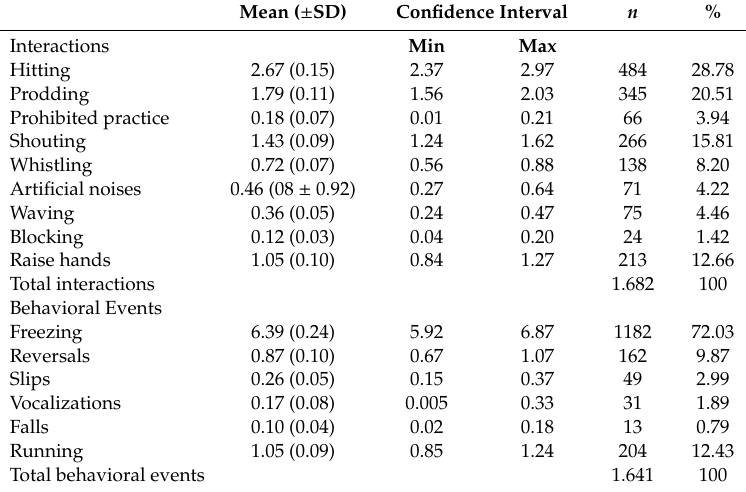
Table 3. Adjusted means and Deviation Standard ( ± SD), confidential interval, number and proportion (%) of interactions of livestock handler (per min) and individual behavioral events of steers (per min) observed during handling at livestock market.